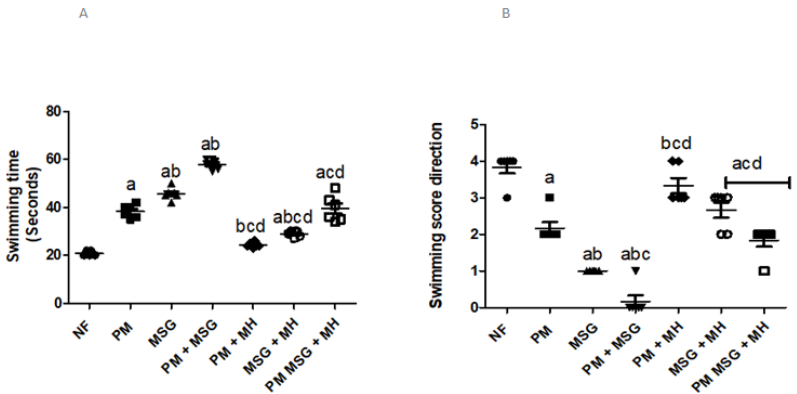
Figure 3. MH affects swimming test of PM and/or MSG—fed rat pups. Effect of 60 mg/kg Morin hydrate (MH) on low protein diet (PM) and/or 0.4 g/kg MSG on swimming time ( A ) and swimming direction score ( B ) using swimming test. Data presented as mean ± SEM ( n = 6). a–d refers to significance from NF, PM, MSG, PM + MSG, respectively, at p < 0.05. Statistical analysis was performed using one-way ANOVA, followed by Tukey’s post hoc test. [The data of the effect of MH on the control NF is not shown as it is not